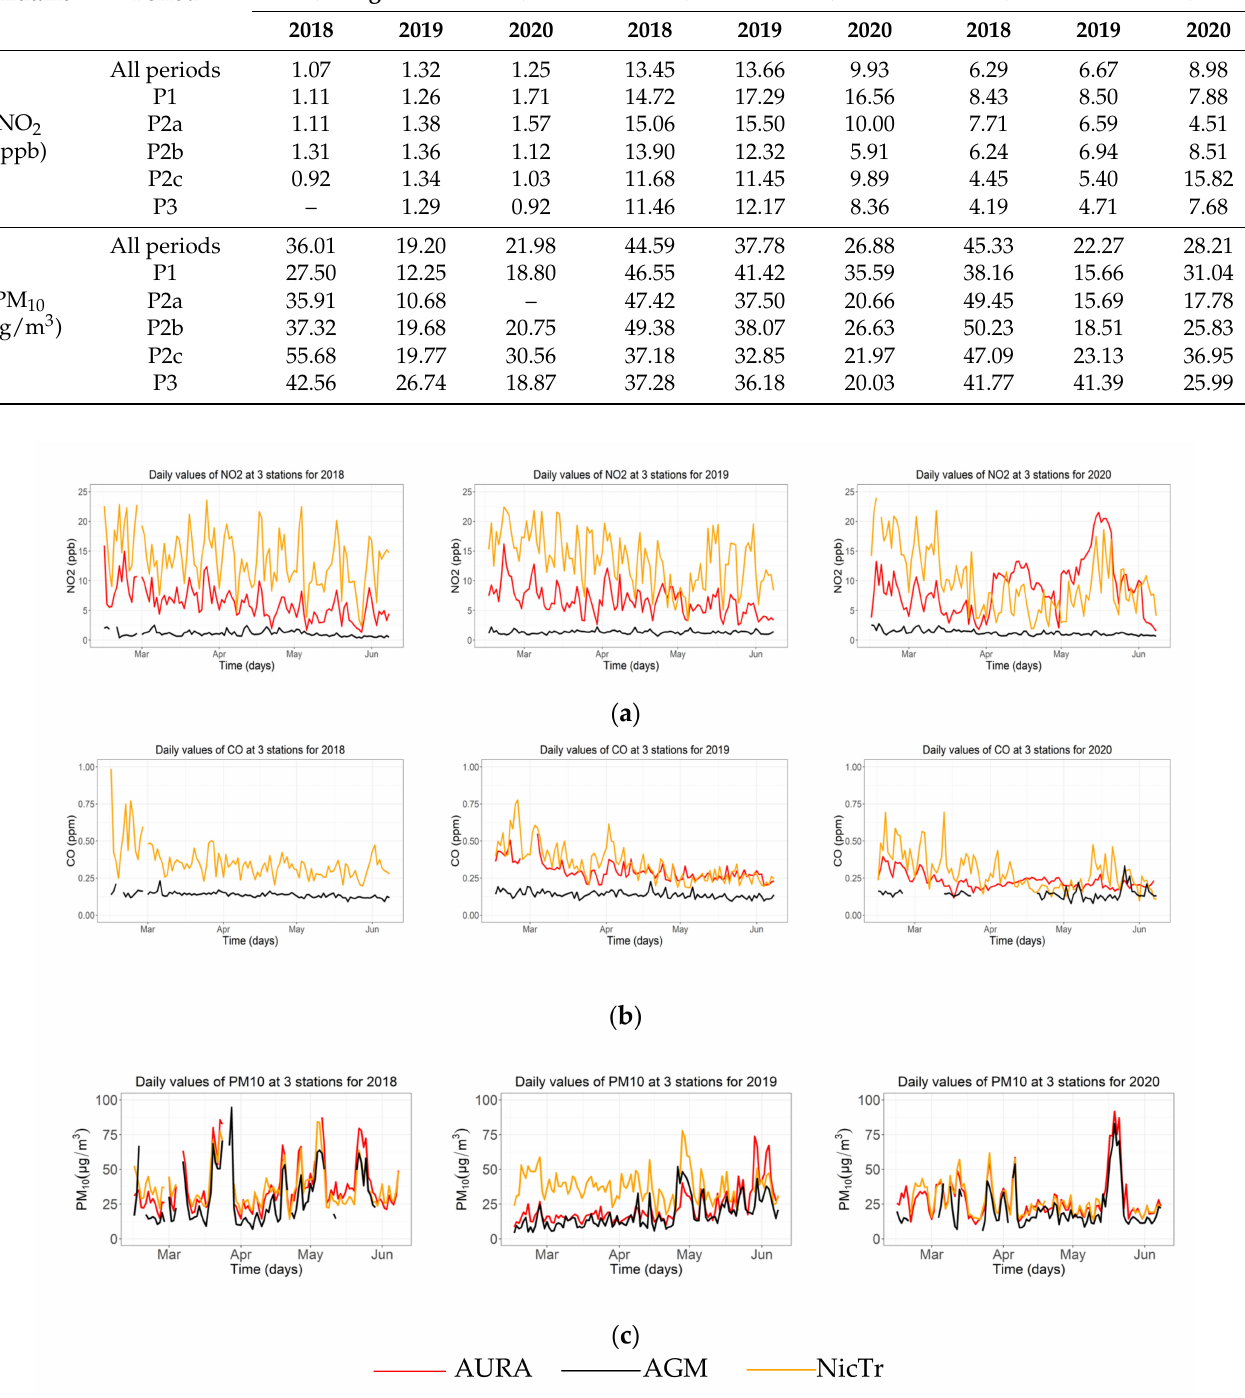
Figure 7. The daily averages of the concentrations of the three pollutants ( a ) NO 2 , ( b ) CO, ( c ) PM 10 in 2018, 2019 and 2020 at three different stations: the AURA station (red), the AGM background station (black line) and for NicTr station (orange